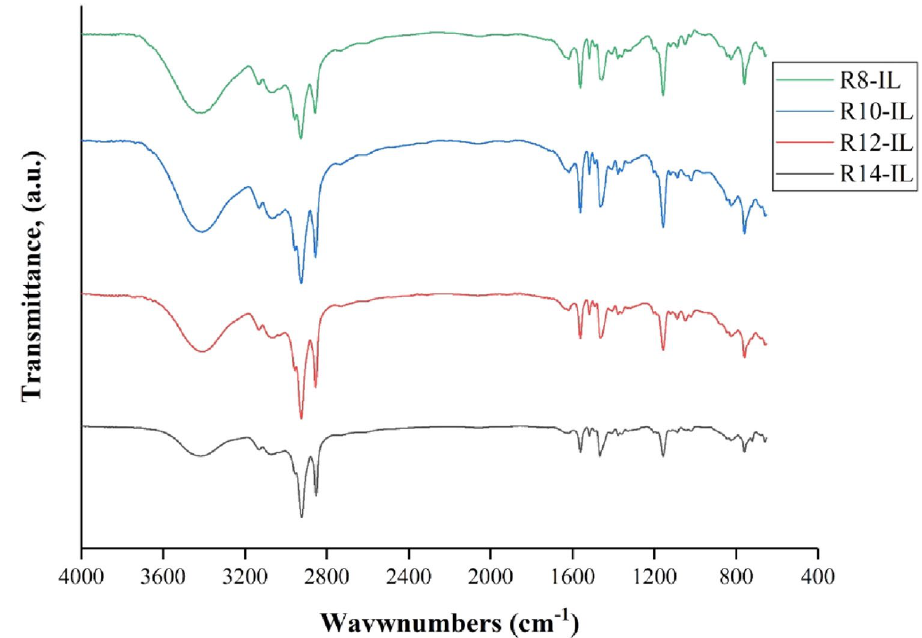
Figure 2. FTIR spectra for the prepared ionic liquids.